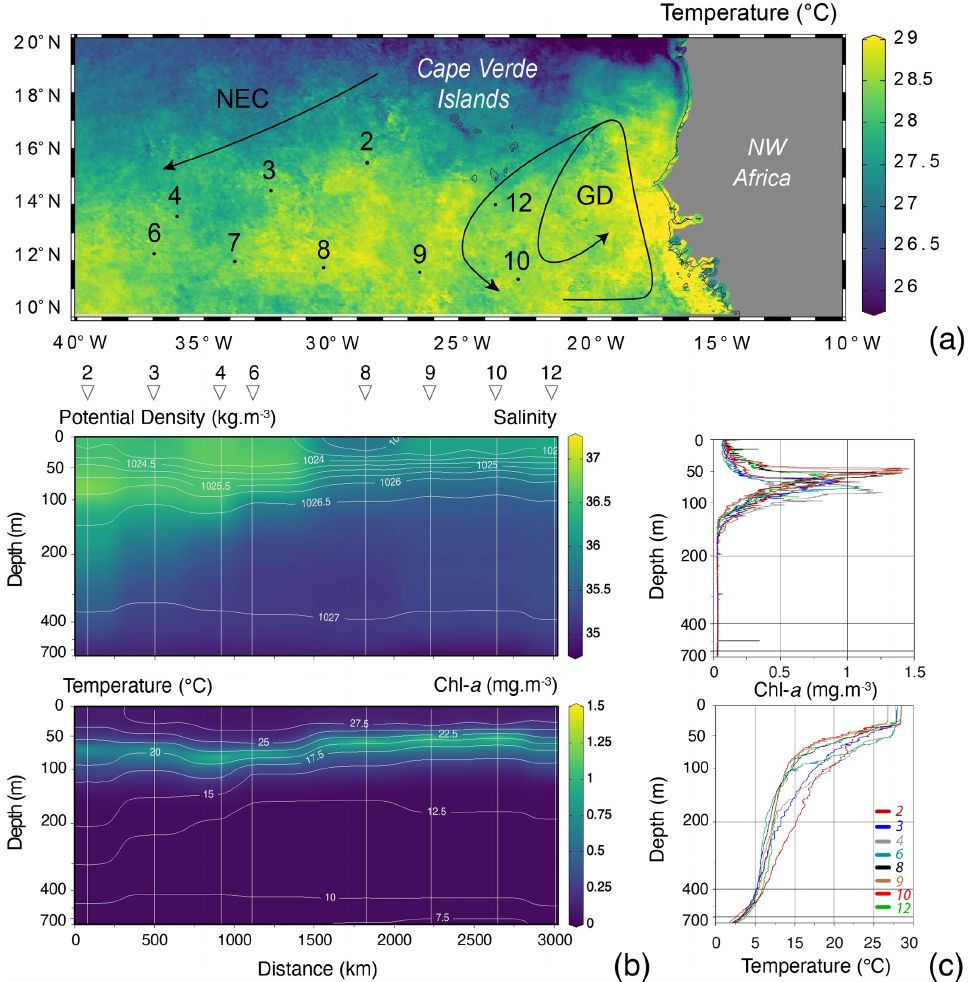
Figure 2. (a) Map of the study area showing the position of the studied vertical profiles (black dots with numbers), remotely sensed sea- surface temperature ( z axis; August 2017, aqua-MODIS 4km resolution, data produced with the Giovanni online data system, developed and maintained by the NASA GES DISC), with the North Equatorial Current (NEC) and the Guinea Dome (GD) highlighted by black arrows (following Fieux, 2021, and references therein). (b) CTD salinity section with isopycnals (white, ranging from 1023 at the surface to 1027 below 300m) and Chl- a concentration (mgm − 3 ) with isothermals (white, ranging from 27.5 at the surface to 7.5 ◦ C below 600m) and with stations highlighted by straight vertical white lines, triangles and numbers on top of the plot (no CTD profile was recorded for station 7). (c) Station profiles (coloured lines) of Chl- a concentration (mgm − 3 ) and temperature ( ◦ C). For all plots, the x axis is stretched in the top to allow a better observation of the mixed layer depth (MLD). Figures were drawn by Ocean Data View (Schlitzer, 2015).